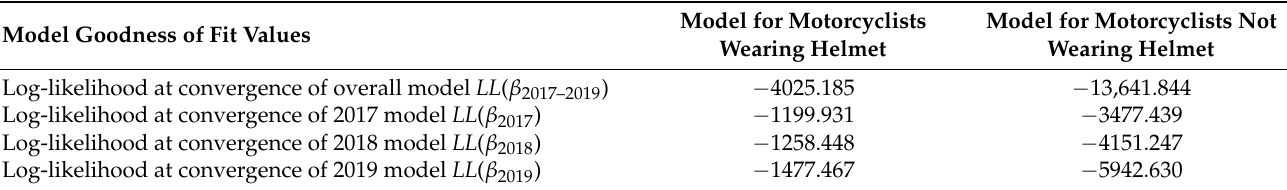
Table 3. Results of temporal instability for helmet-wearing and non-helmet-wearing